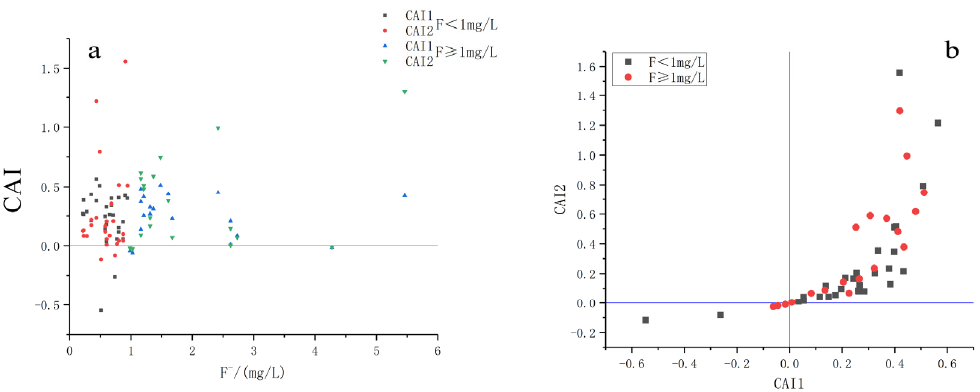
Figure 6. Chloro-alkaline indices (CAI) used to describe cation exchange; ρ [F − ] and CAI of ground- Figure 6. Chloro ‐ alkaline indices (CAI) used to describe cation exchange; ρ [F − ] water samples ( a ); CAI1 and CAI2 of groundwater samples ( b and CAI of groundwater samples( a ); CAI1 and CAI2 of groundwater samples( b ).